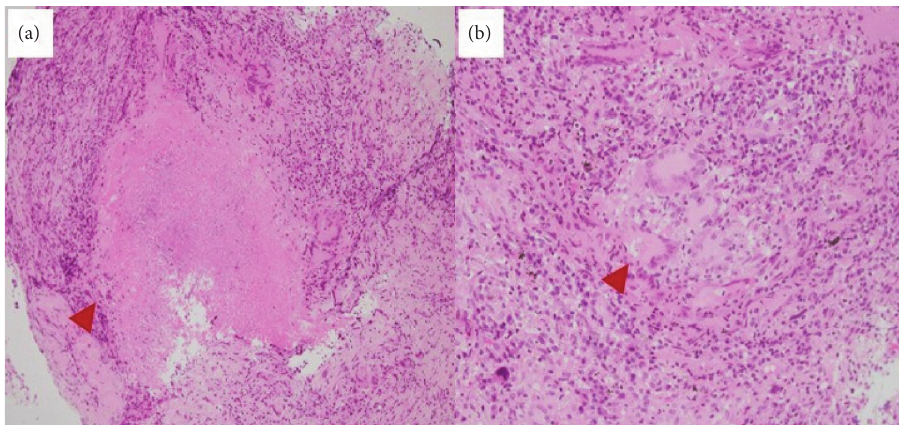
Figure 2: Histological findings revealed epithelioid granulomas with caseous necrosis and infiltration of lymphocytes with hematoxylin and eosin staining. (a) × 100 manifestation; (b) × 200